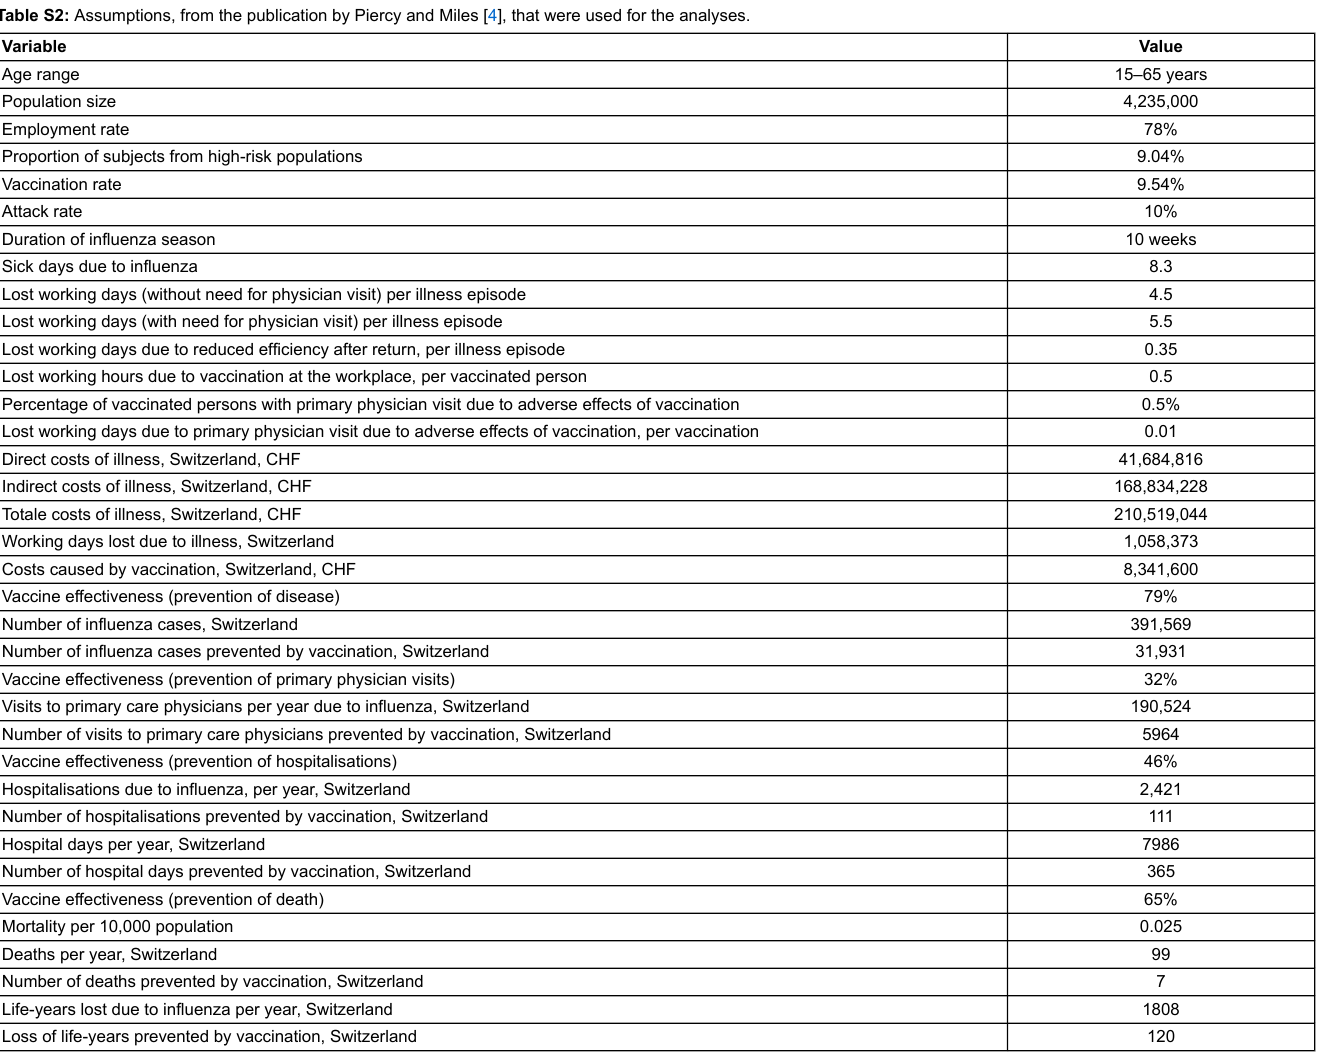
Table S2: Assumptions, from the publication by Piercy and Miles [4], that were used for the analyses.